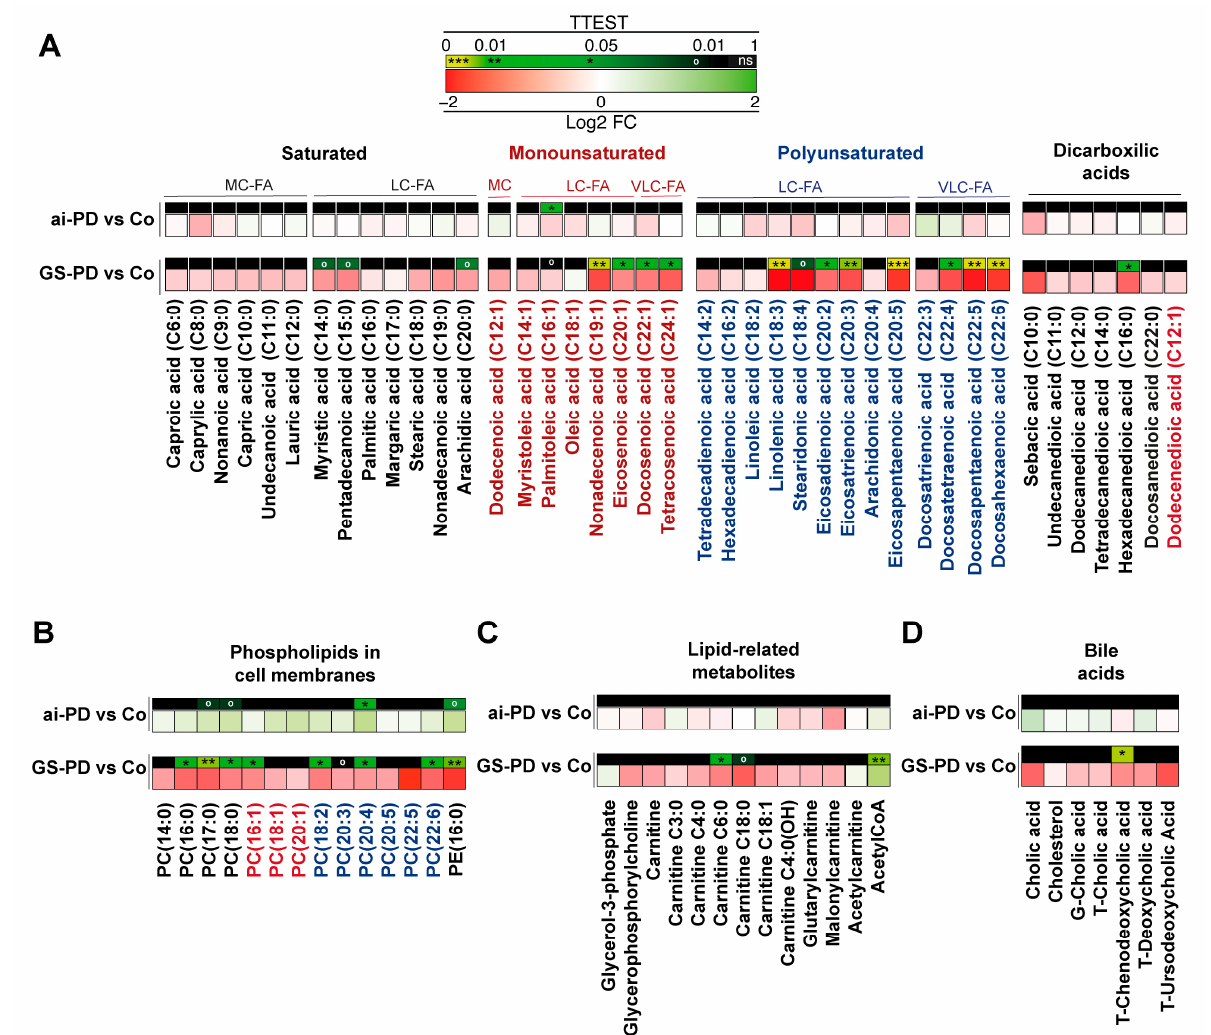
Figure 4. Heatmaps showing the TTEST ( p value) on the square above, and log 2-fold change (Log2 FC) on the square below for the different concentration of fatty acids (FA) ( A ), phospholipids in cell membranes ( B ) lipid-related metabolites ( C ) and bile acid metabolites ( D ) in the liver of WT group and genetic (carrying the p.G2019S mutation in LRRK2 ; GS-PD) and acute intoxication PD (ai-PD) mouse models ( n = 4–5). For statistical data, p -values were estimated by one-way ANOVA (analyzing the metabolites separately) and differences were considered significant when p -values were: ◦ ( p < 0.1), * ( p < 0.05), ** ( p < 0.01) and *** ( p < 0.001). G, glycine; LC, long-chain; MC, medium-chain; PC, phosphatidylcholine; PE, phosphatidylethanolamine; T, taurine; VLC, very long-chain.